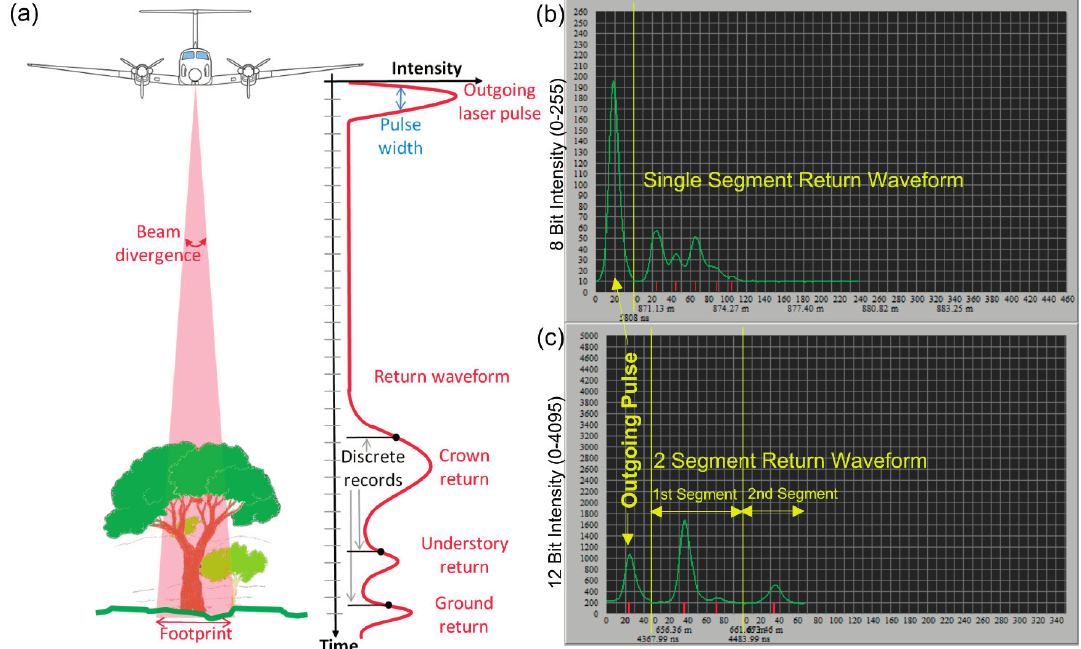
Figure 4. Illustration of LASER beam divergence and outgoing and return signals (waveforms). ( a ) Path of the LASER pulse; ( b ) waveform digitized with a 8-bit amplitude in a single segment; ( c ) waveform digitized with a 12-bit amplitude in multiple